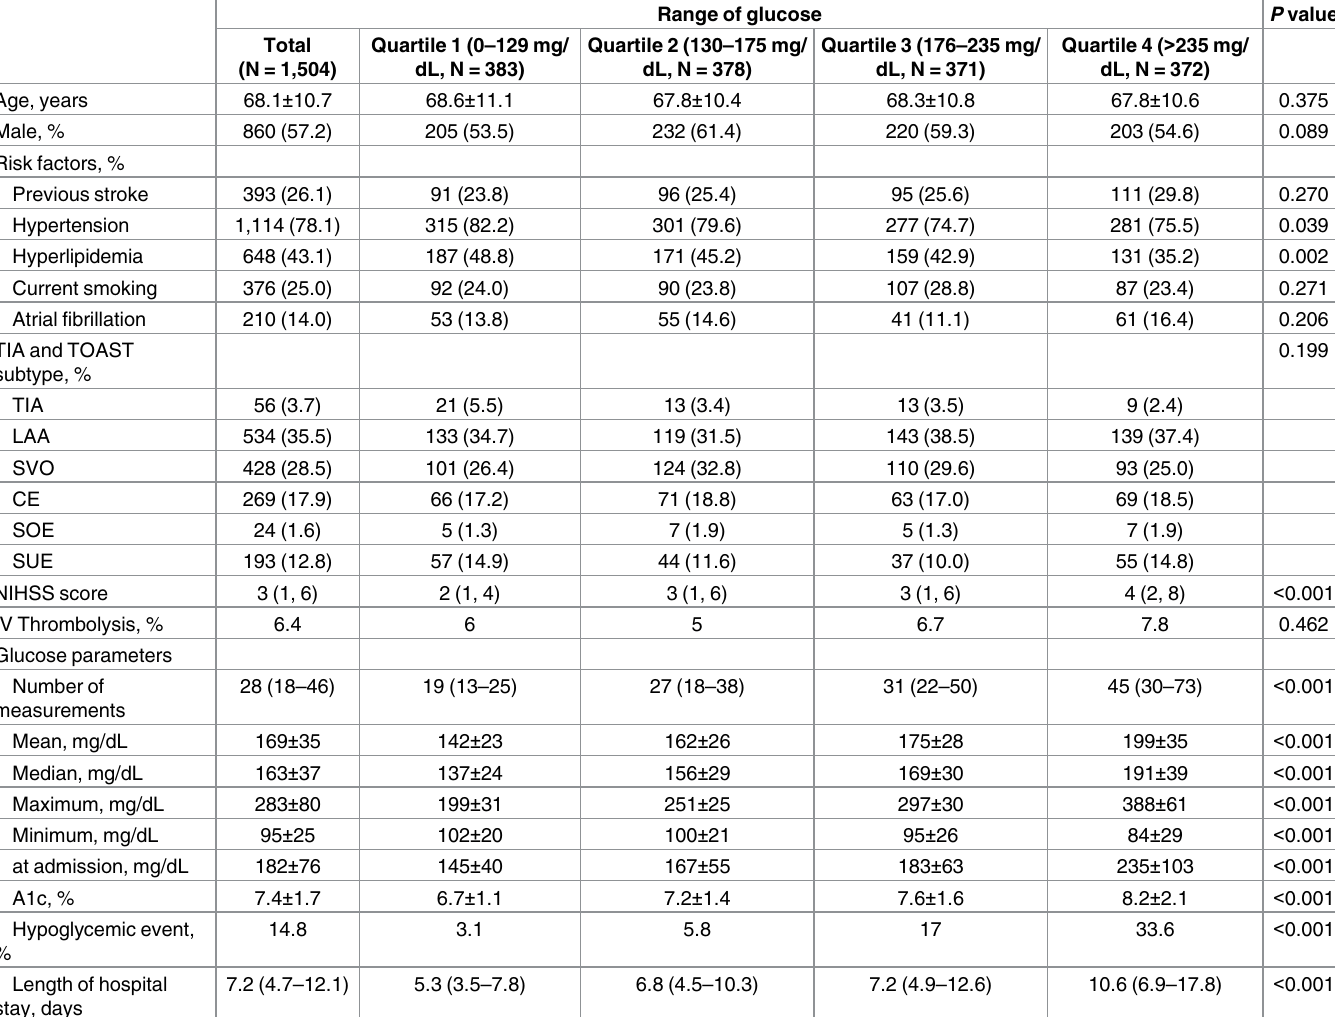
Table 1. Baseline